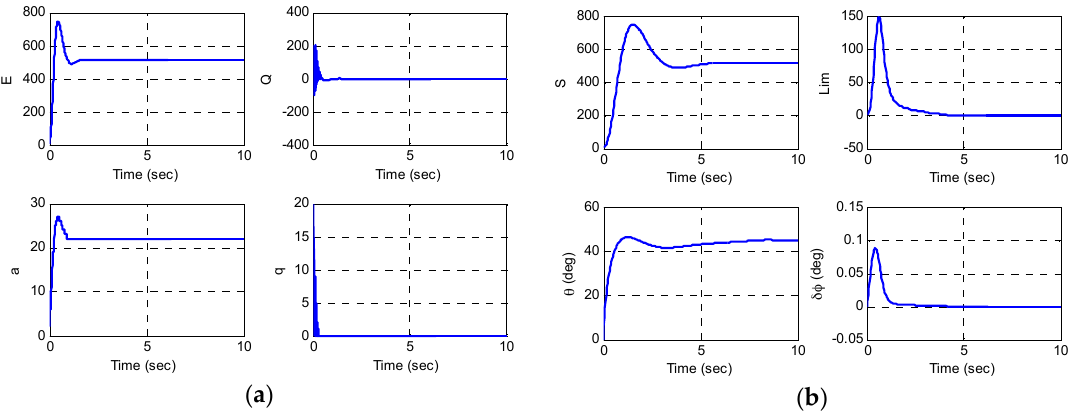
Figure 13. Matlab/Simulink simulation results; control varialbes: ( a ) the amplitude and quadrature control variables; ( b ) the rate and phase control variables.